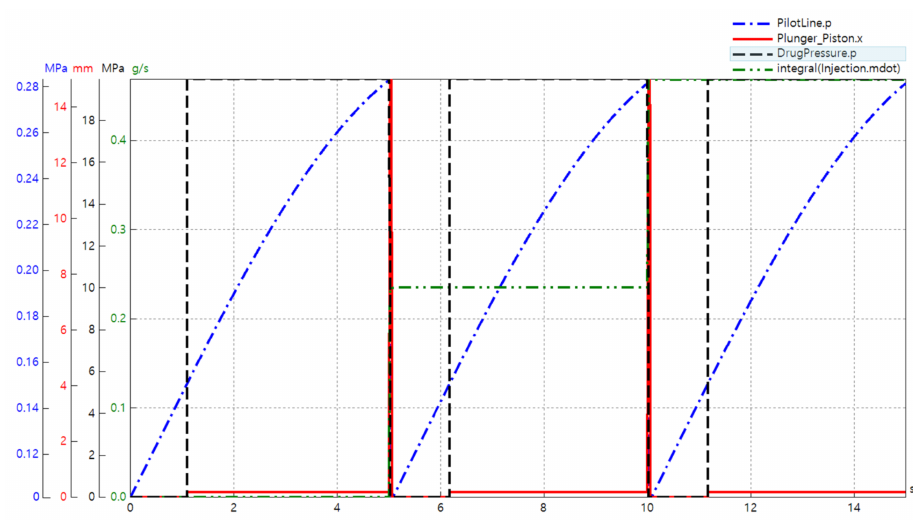
Figure 11. NFJIS numerical analysis results by SimulationX from the developed model.